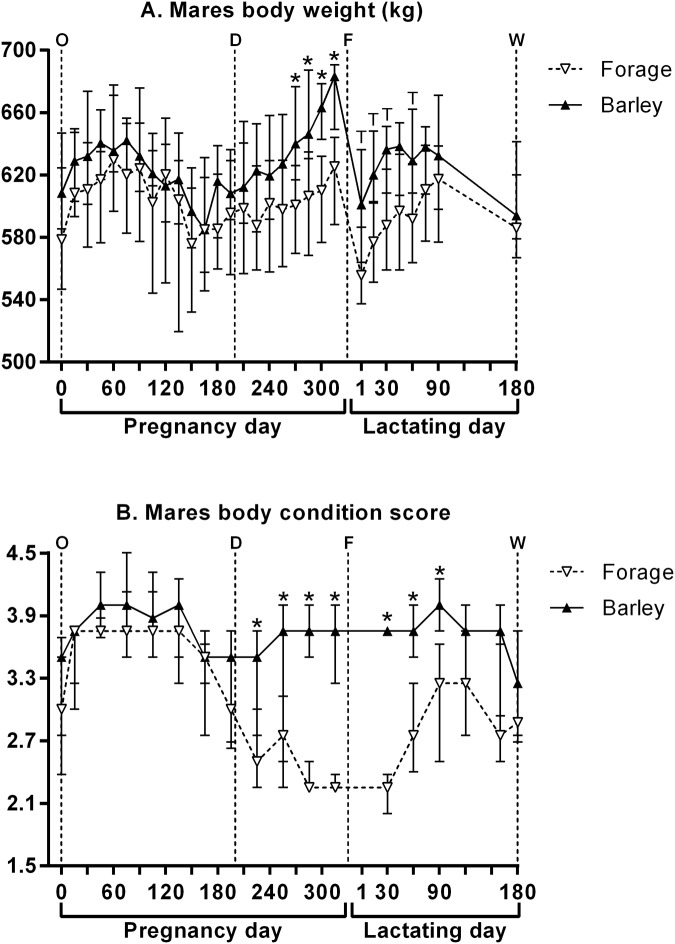
Mares’ bodyweight (A) and body condition score (B) (median and IQR) throughout pregnancy and lactation.O: ovulation, D: start of the diet, F: foaling, W: weaning. Values under the asterisks significantly differ between groups and those under letter “T” tend to differ between both groups (Mann-Whitney with FDR adjustment).